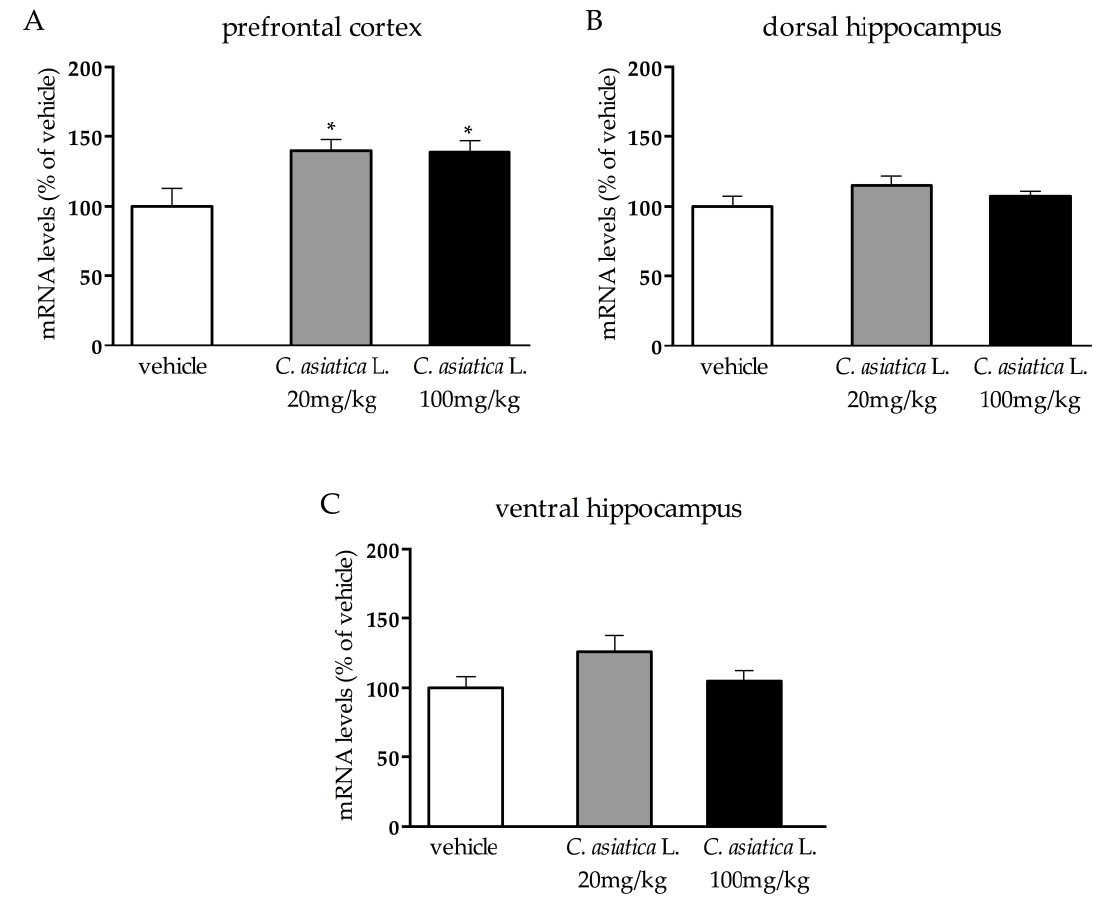
Figure 2. Analysis of total Bdnf mRNA levels in the prefrontal cortex ( A ), in the dorsal hippocampus ( B ), and in the ventral hippocampus ( C ) of rats that were chronically treated with 20 or 100 mg / kg of C. asiatica L. The data are expressed as a percentage of the vehicle (set at 100%) and are represented as the mean SEM of at least five independent determinations. * p < 0.05 vs vehicle (one-way ANOVA with Fisher’s